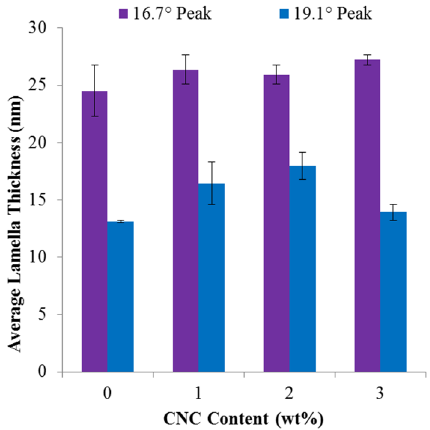
Figure 5. Average crystal lamella thickness of the two dominant diffraction peaks, 16.7° and 19.1°, for the CNC/PLA films as a function of CNC content.